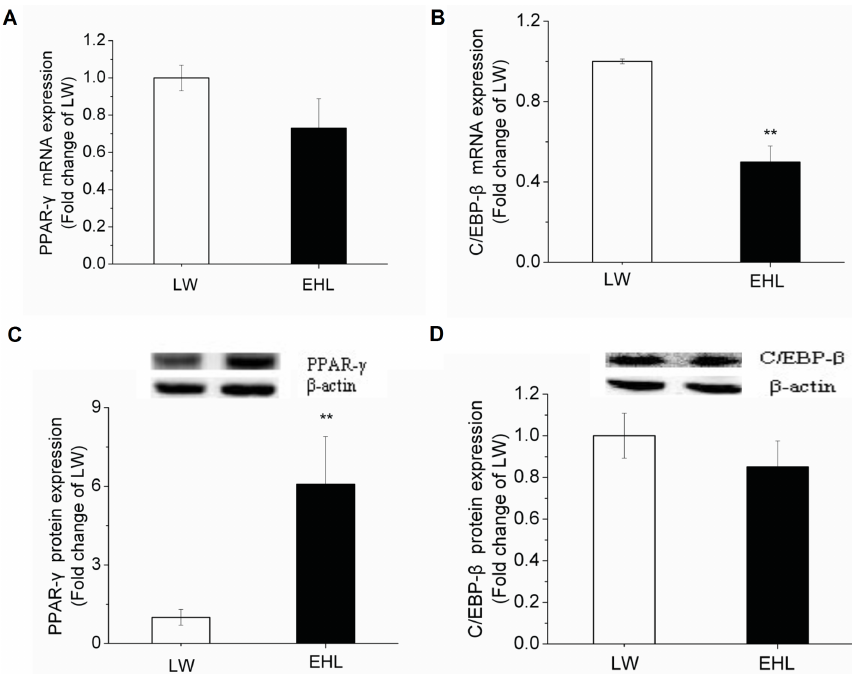
Figure 1. mRNA and protein expression of genes involved in adipogenesis in the subcutaneous fat of LW and EHL pigs. (a) PPAR γ mRNA expression, (b) C/EBP β mRNA expression, (c) PPAR γ protein expression, (d) C/EBP β protein expression. The values shown represent the mean ± standard error, n = 6; ** P <0.01 vs.